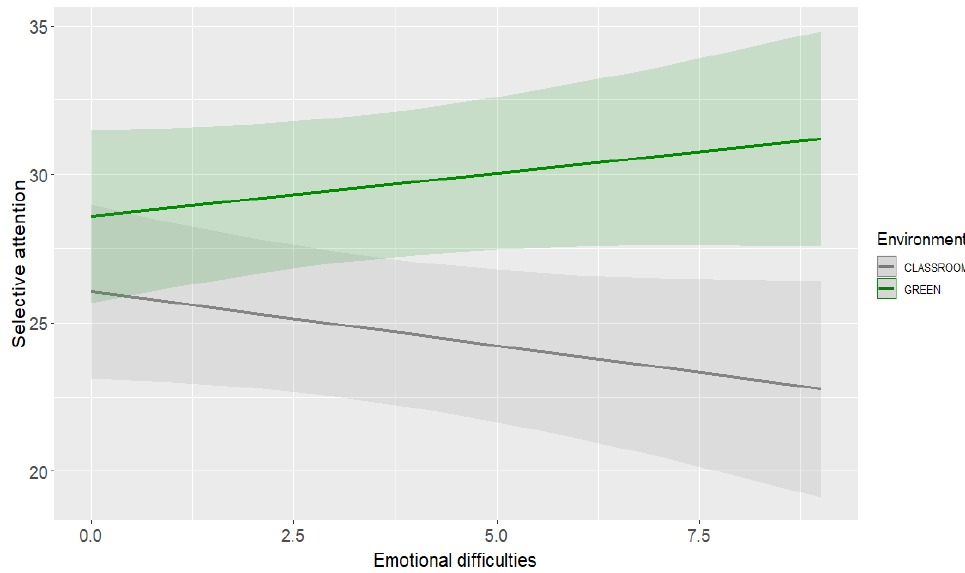
Figure 2. Interaction effect of environment and emotional difficulties on selective attention.